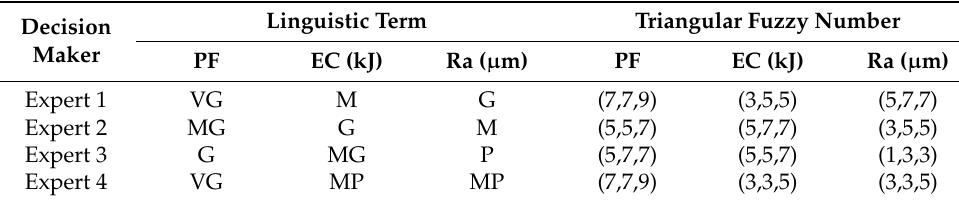
Table 3. Experimental dataset on green dry milling of SS 304